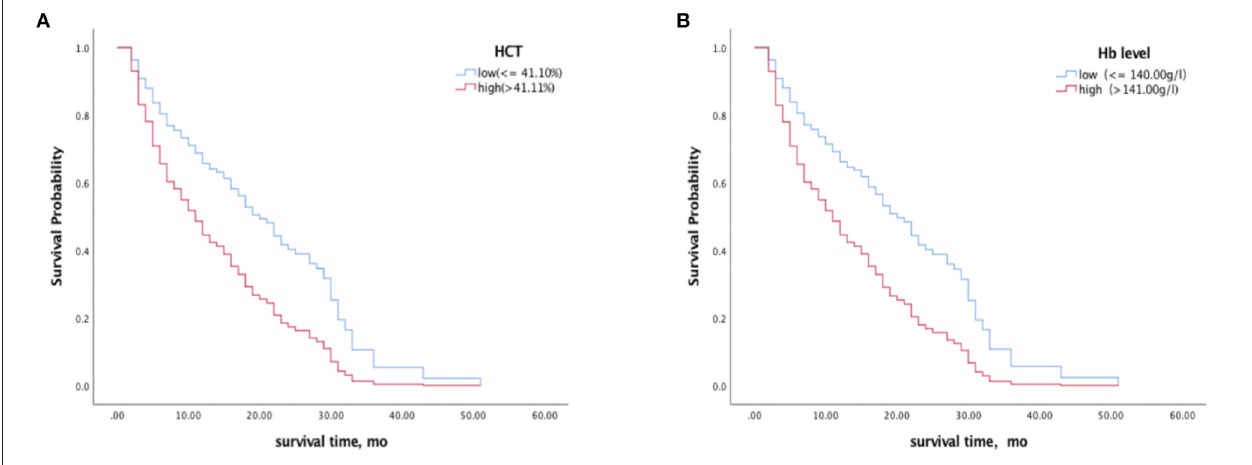
FIGURE 3 | Survival analyses of CJD patients with high vs. low HCT (A) and Hb (B) levels. A median split was conducted on HCT (41.10%) and Hb (140.00 g/l) levels. Higher baseline Hb and HCT levels were associated with a shorter survival